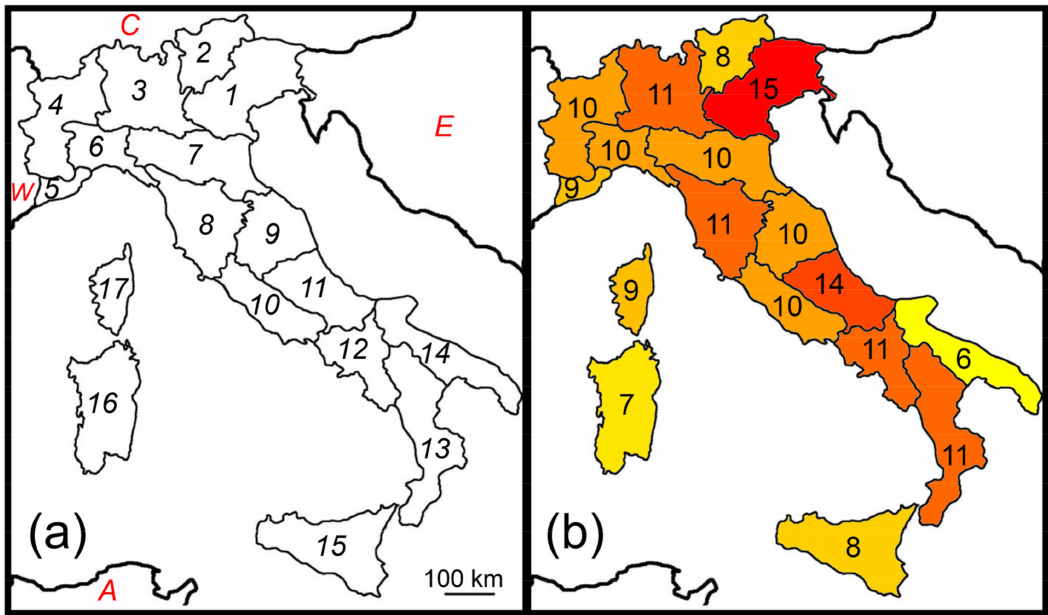
Figure 1. Species richness patterns of Italian earwigs. ( a ) Italian natural regions (numbered from 1 to 17) and major adjacent areas (W: Western Europe; C: Central Europe; E: Eastern Europe; A: Northern Africa); ( b ) Number of total earwig species in each